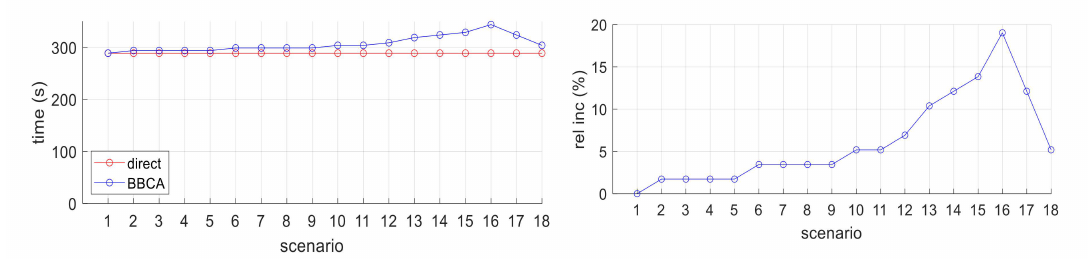
Figure 13. Two-UAV study: flying time; absolute values (left) and relative increment (right).